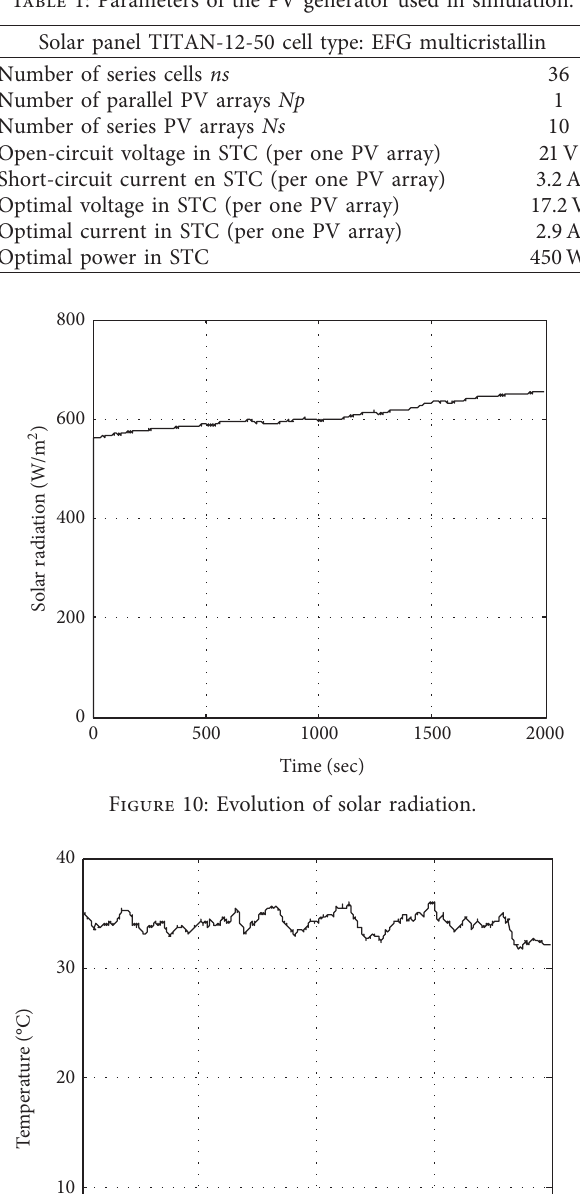
Figure 13: Evolution of real and reference powers of